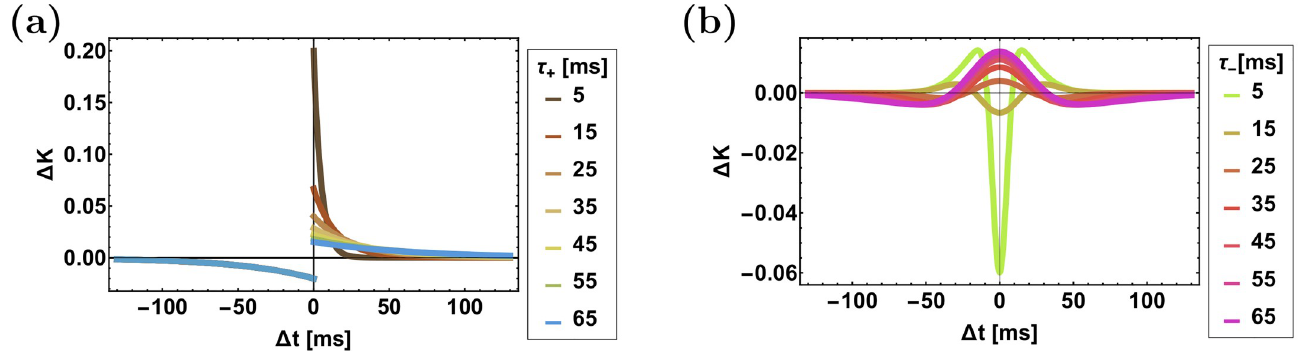
( Δ t ), of the STDP rules are shown as a function of pre-post spike time difference, Δ t = t −